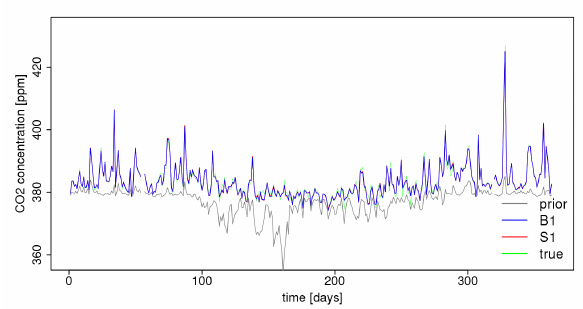
Figure 3. Daily nighttime (23:00–04:00UTC) averages for prior, true and posterior CO 2 dry mole fraction time series for the moun- tain site Schauinsland. Time starts at 1 January 2007. Note that due to the almost perfect fit, posterior and true time series